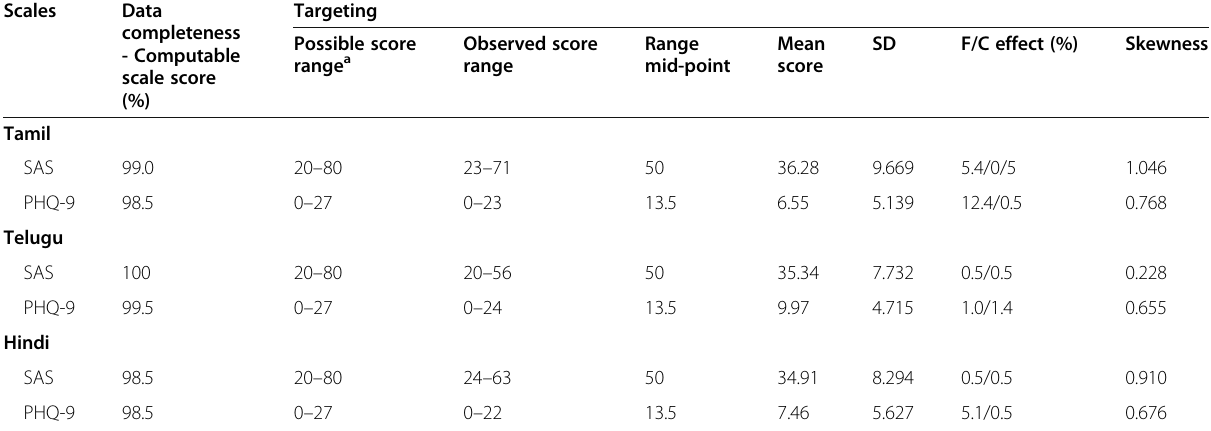
Table 2 Scale level analyses – data completeness and targeting of all SAS and PHQ-9 across Tamil, Telugu and Hindi ( n = 621)